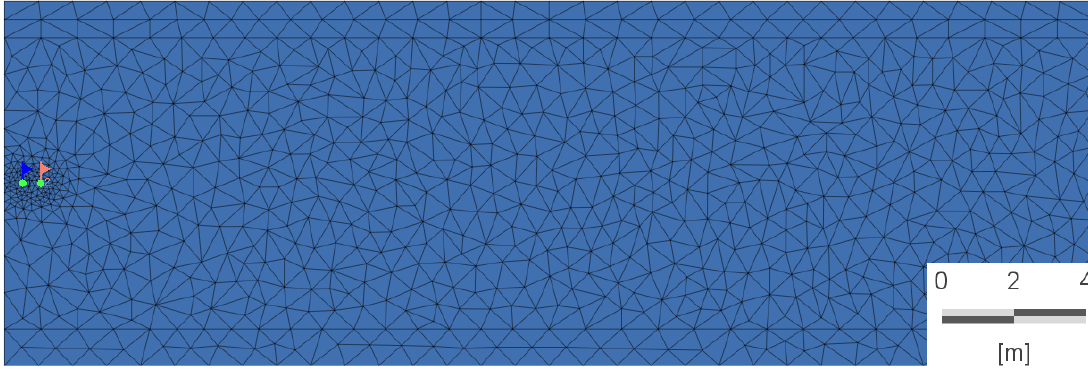
Figure 4. Mesh profile of the example.